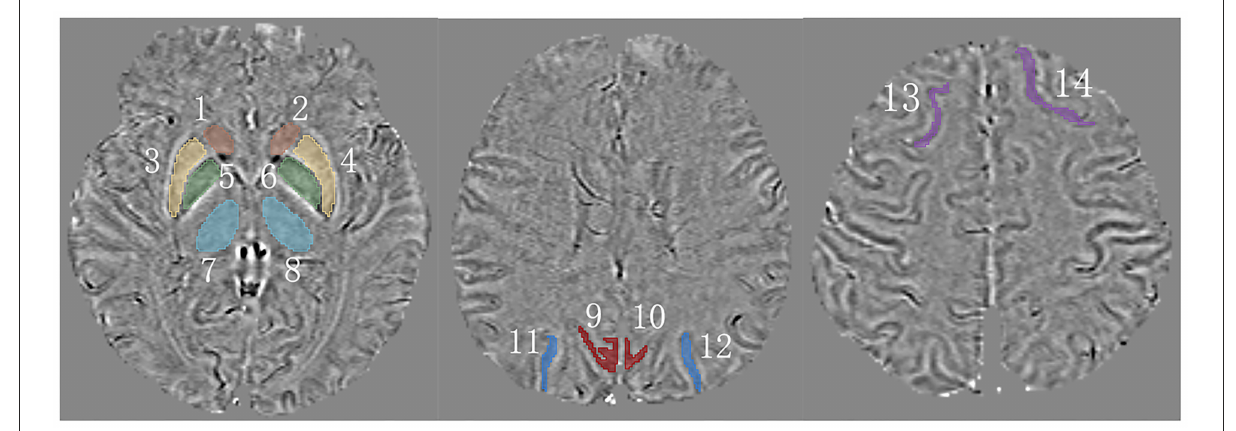
FIGURE2 A schematic of measured regions on QSM. 1,2 = caudate nucleus (CN); 3,4 = putamen (PU); 5,6 = globus pallidus (GP); 7,8 = thalamus (TH); 9,10 = precuneus (PR); 11,12 = superior occipital gyrus (SOG); 13,14 = superior frontal gyrus (SFG).